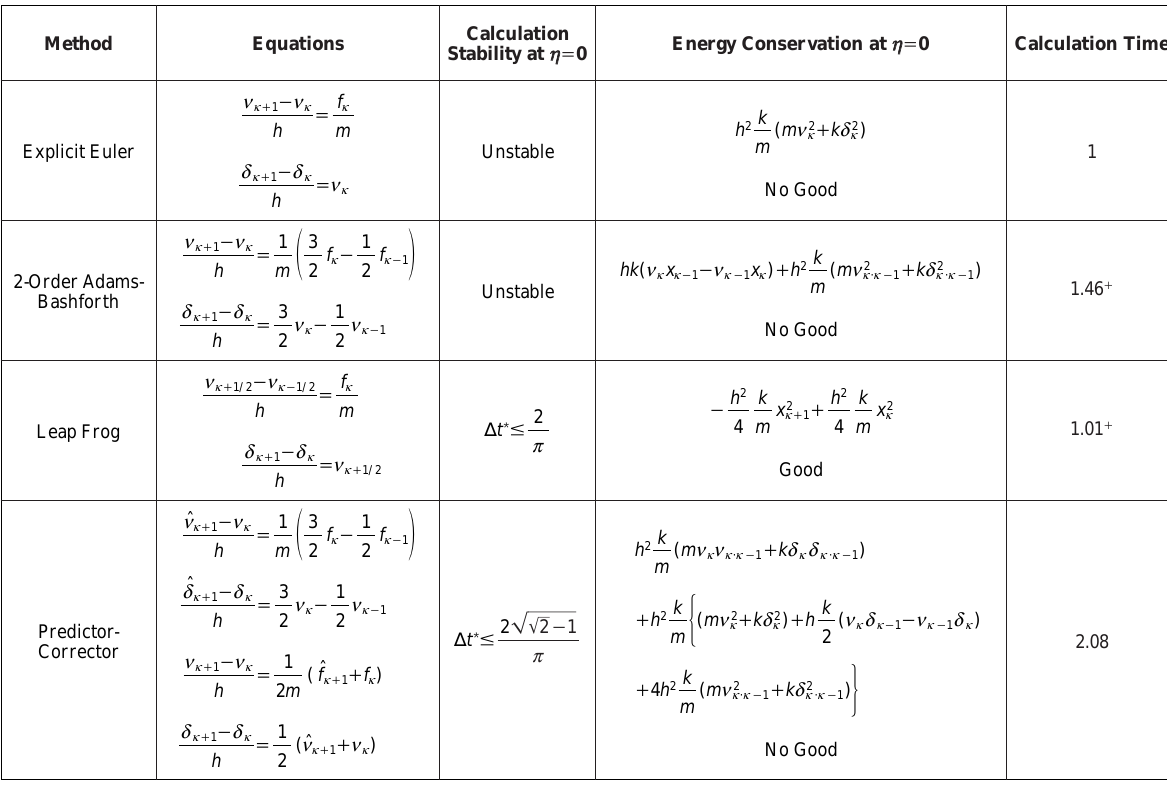
Table 2 Comparison of 4 conventional methods ( k (cid:2) t / ∆ t , h (cid:2) ∆ t